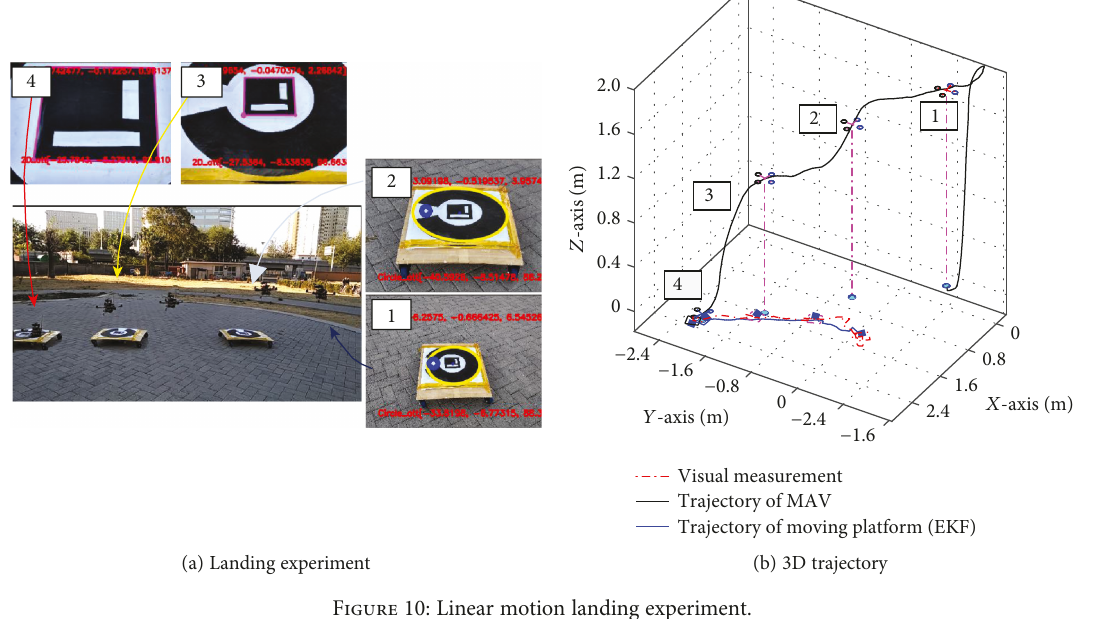
Figure 10: Linear motion landing